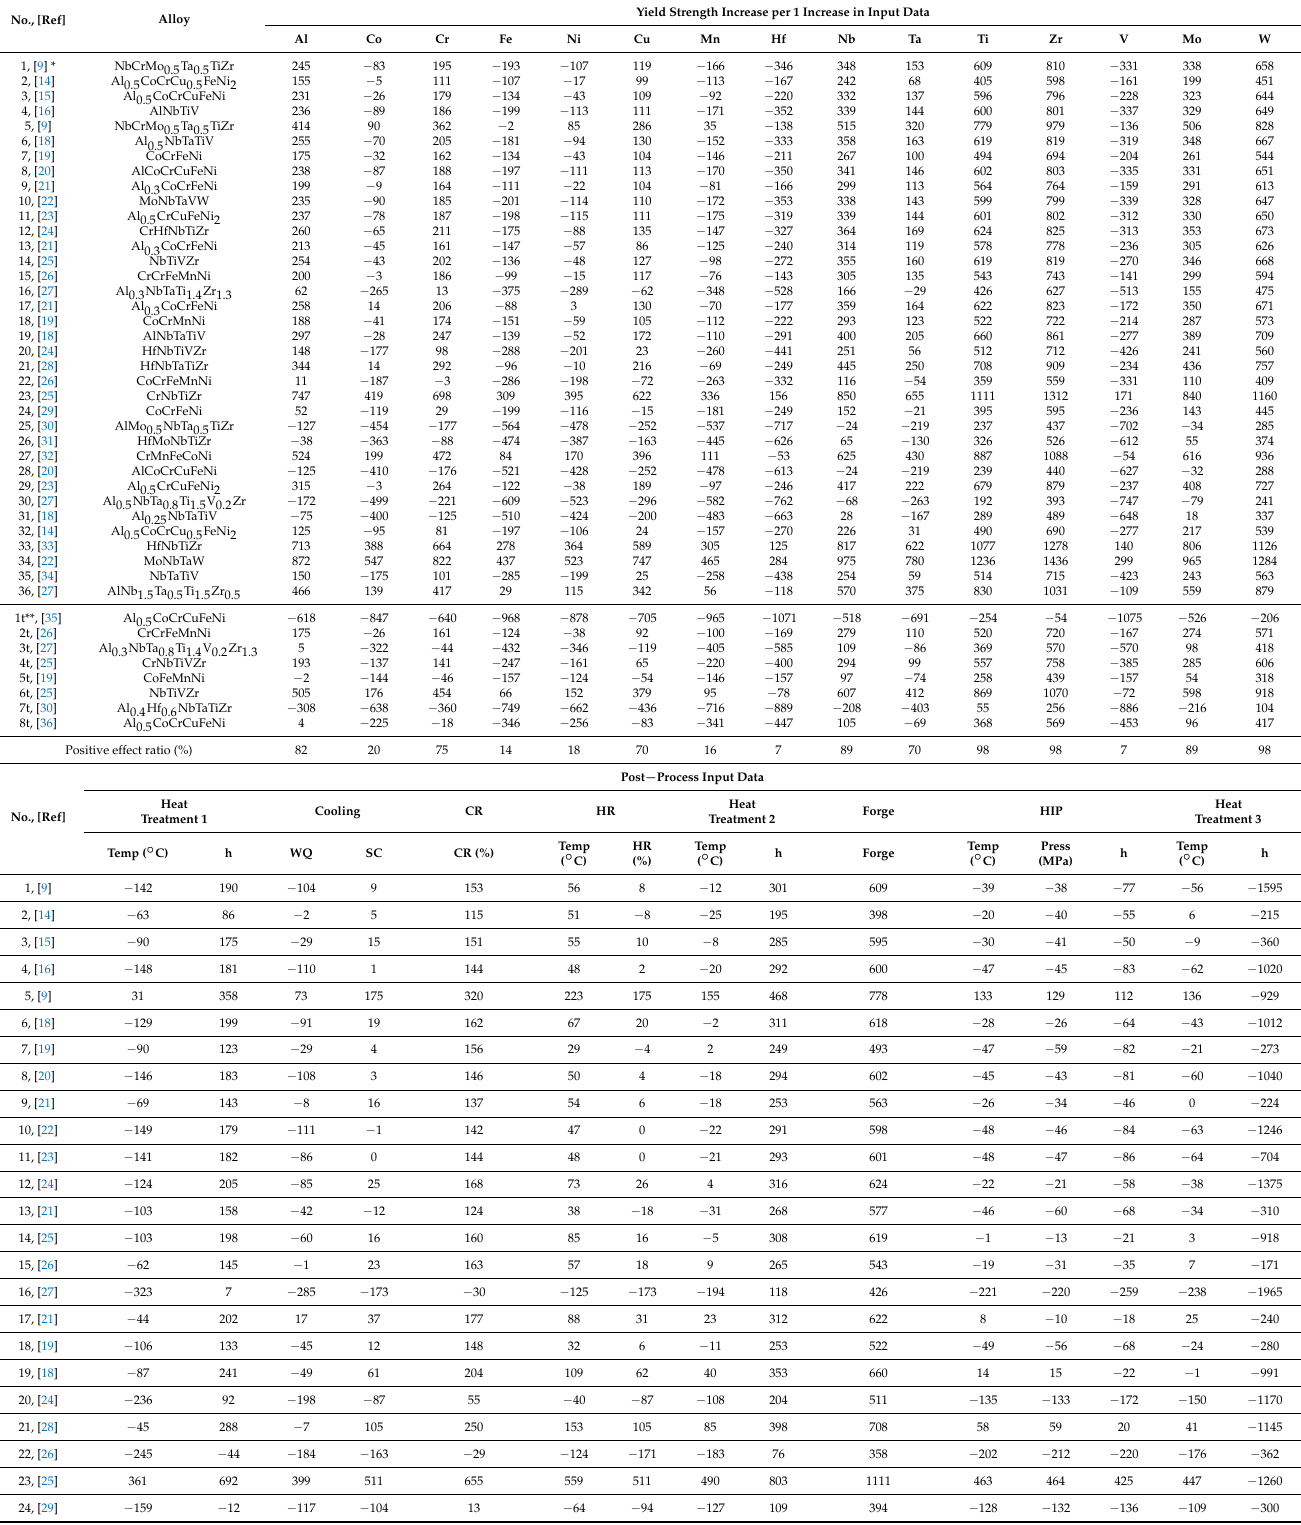
Table 6. Yield strength prediction data set that changes when the input data increases by